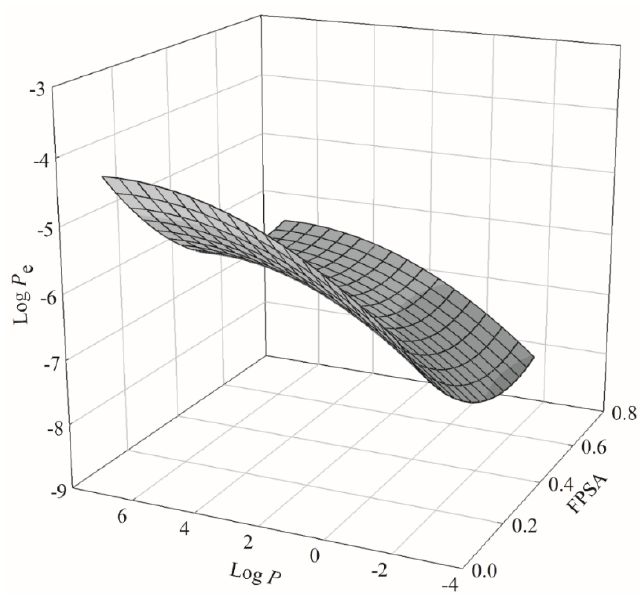
Figure 9. Relationship among log P e , fractional polar surface area (FPSA), and log P in 3D presentation.